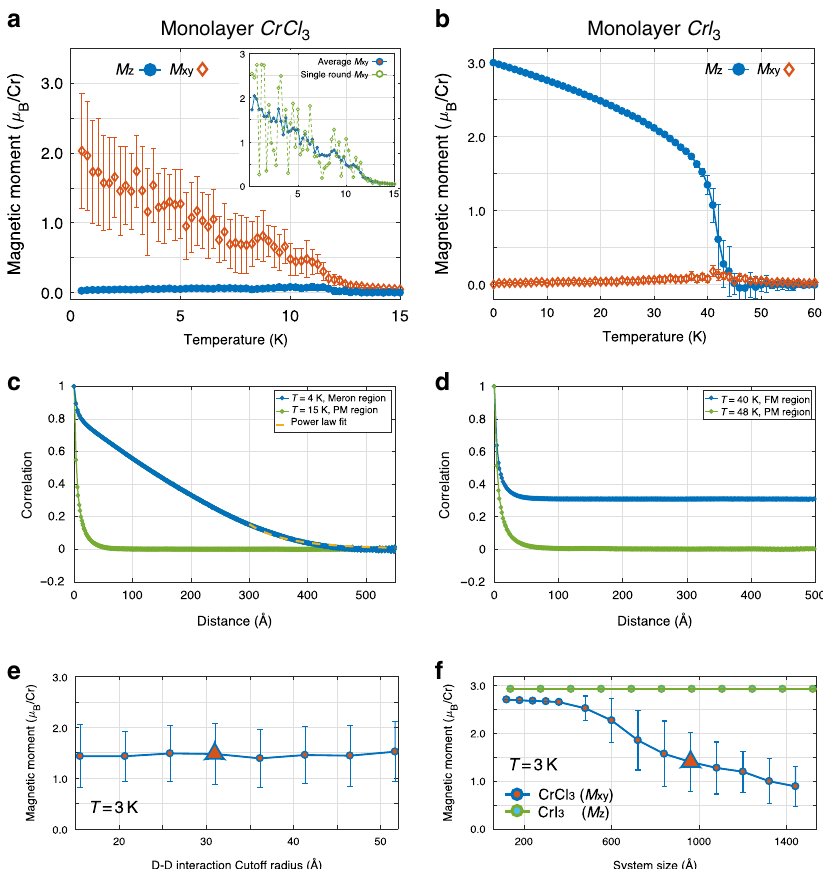
Fig. 2 Monte Carlo simulations of ML CrCl 3 and CrI 3 . a , b are the MC simulated magnetization versus temperature of ML CrCl 3 and CrI 3 , respectively. The inset of ( a ) represents the averaged (blue-red line) and single-round (green dotted line) in-plane magnetic polarization of ML CrCl 3 . c , d The spin-spin correlation function of ML CrCl 3 and CrI 3. e , f The averaged in-plane magnetic polarization at T = 3 K for different D-D interaction truncations and different system sizes. The error bars are the standard